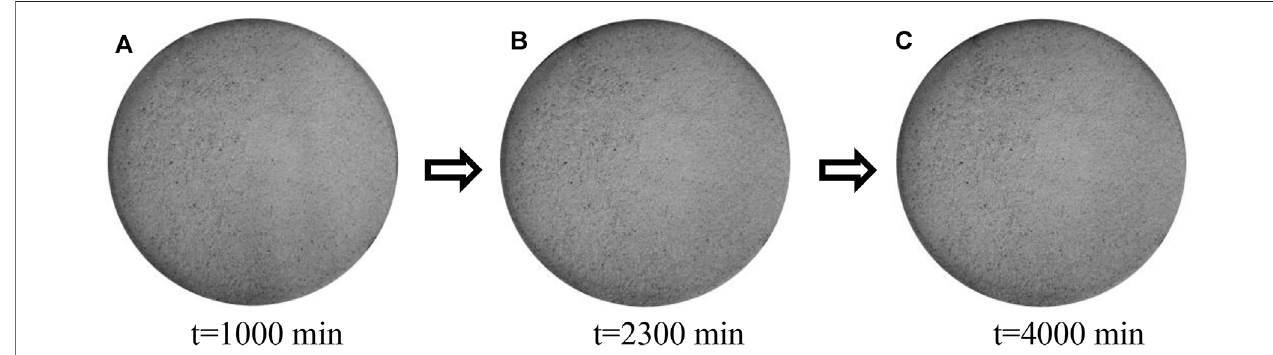
FIGURE 4 | Surface crack development process of the soil sample (clay content of 80%). (A) t =1100 min, (B) t =1150 min, (C) t =1180 min, (D) t =1250 min, (E) t =1350 min, and (F) t =4000 min.